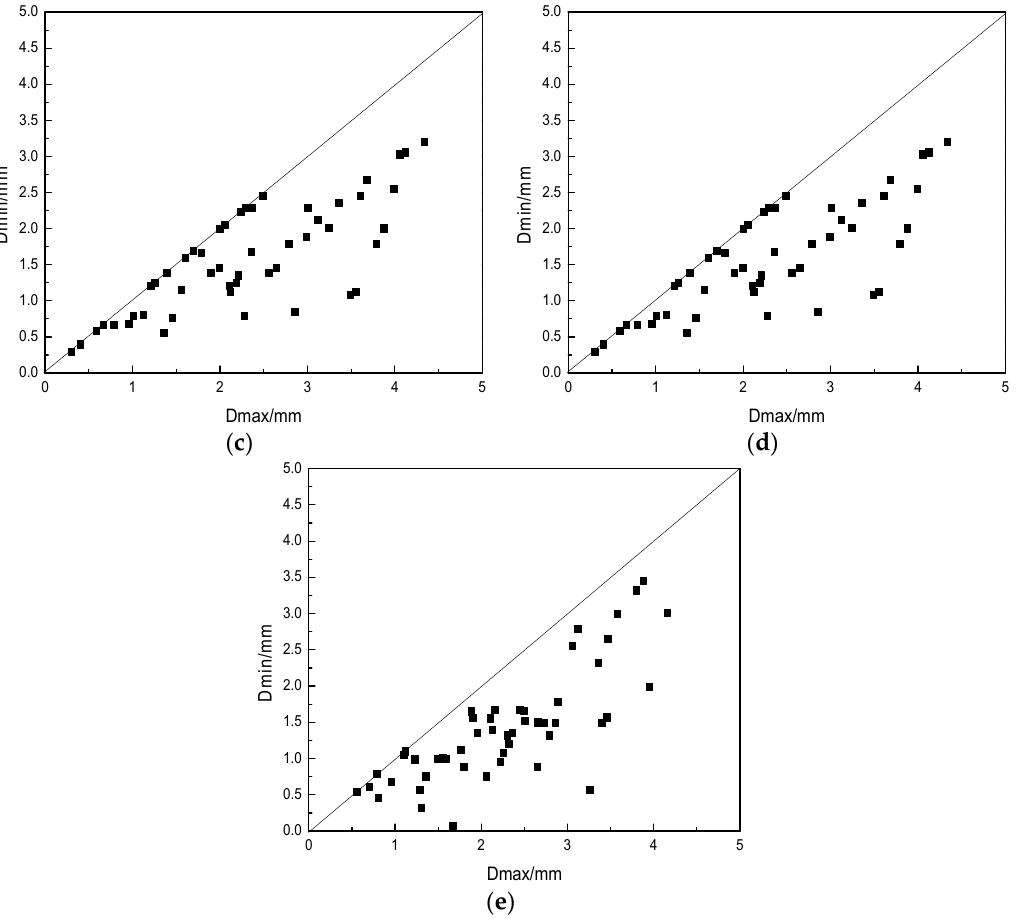
Figure 5. Effect of different basicities on spherical degree. Spherical degree: ( a ) R = 1.2; ( b ) R = 1.1; ( c ) R = 1.0; ( d ) R = 0.9; ( e ) R = 0.8 .